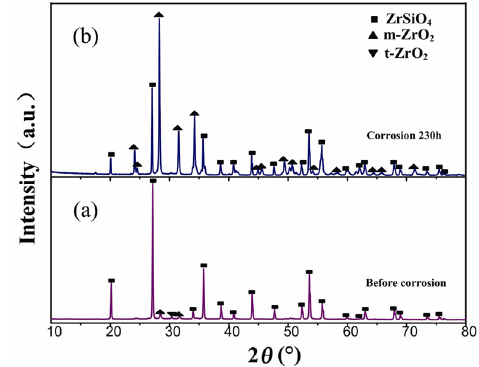
Fig. 3 Phase composition of the ZrSiO 4 bulk (a) before and (b) after